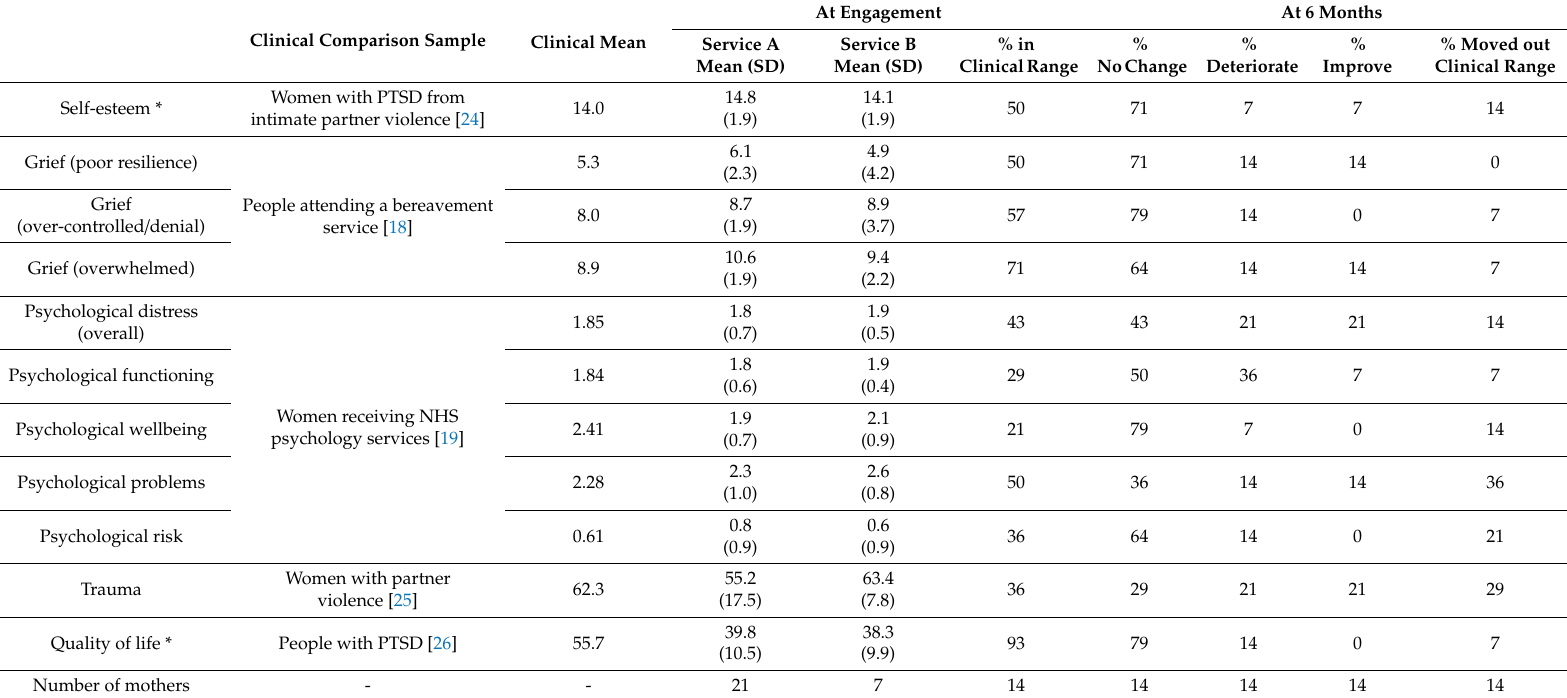
Table 3. Psychological